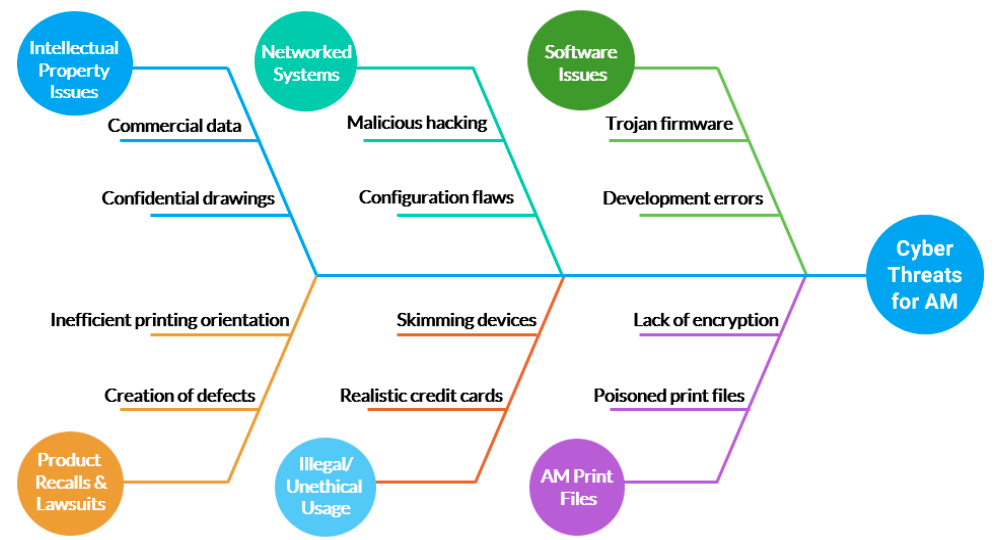
Figure 7. Cyber threats for additive manufacturing.